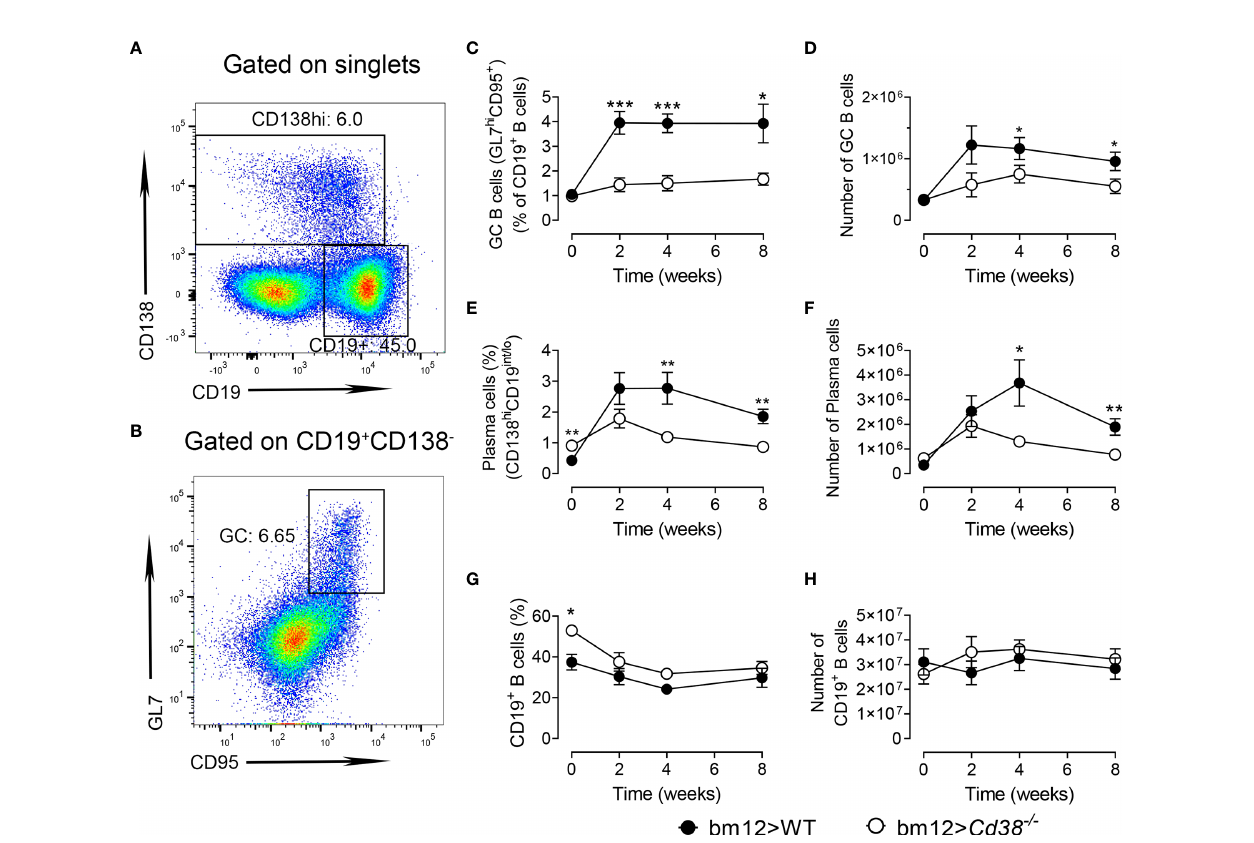
FIGURE 2 | Decreased frequencies of GC B cells and plasma cells upon induction of chronic graft- versus -host disease (cGVHD) in Cd38 − / − recipients. WT (closed circles) and Cd38 − / − (open circles). (A) Representative fl ow cytometry plot showing CD19 lo-int CD138 hi plasma cells and CD19 + CD138 − B cells from the spleen cells gated on singlets. (B) Flow cytometry plot of CD95 + GL7 hi GC B cells from gated CD19 + CD138 − cells. (C) Percentages of GC B cells (of CD19 + B cells). (D) Total number GC B cells. (E) Percentages of plasma cells in spleen cells. (F) Total number of plasma cells in spleen cells. (G) Percentages of CD19 + B cells in the spleen. (H) Total number of CD19 + B cells over time upon the adoptive transfer of bm12 cells. In panels (C – H) WT mice (closed circles) and Cd38 − / − mice (open circles). The symbols are the mean values and the vertical bars represent ± SEM. P -values are shown for Welch ’ s t -test. The results are cumulative data from two to four different experiments per time point and mouse type, each with three to fi ve mice per experiment. * P < 0.05, ** P < 0.01, *** P <